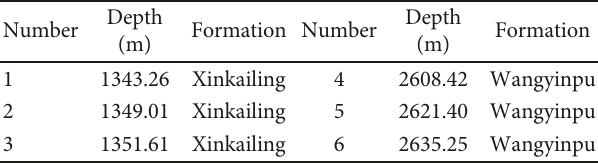
Table 3: The number, depth, and formation of the samples used in the inclusion analysis. See Figure 1 for the well locations.